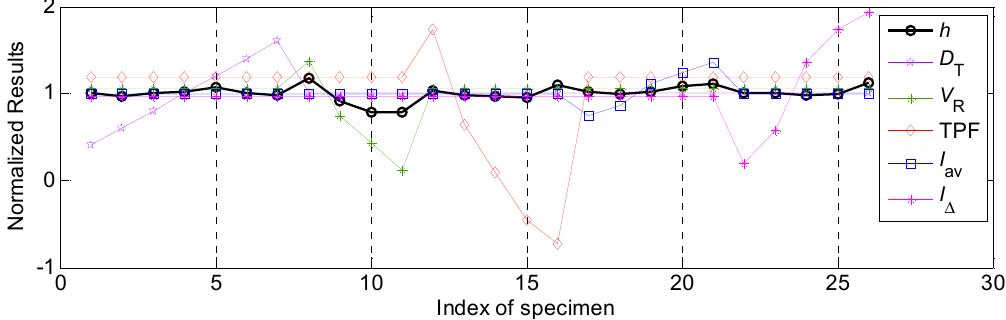
Figure 7. The normalized results of various process parameters and bead height after linear transformation for special parameters.